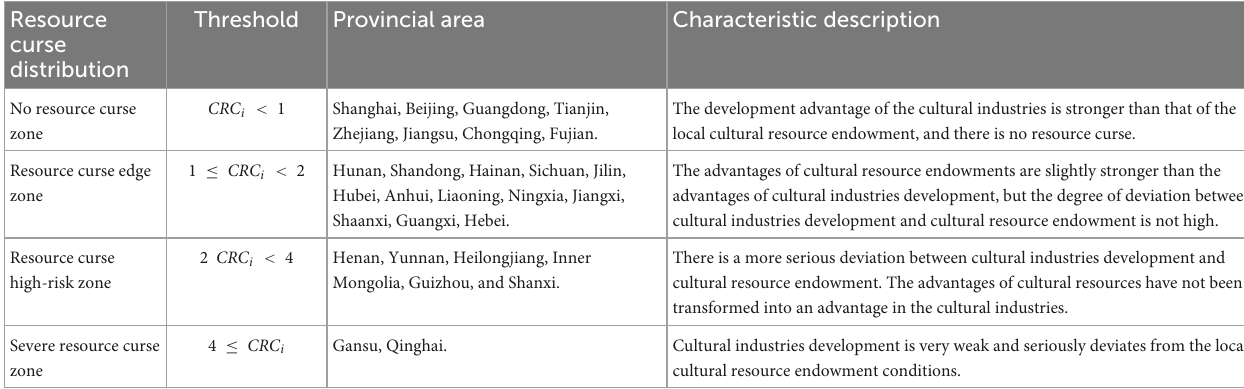
TABLE 2 Regional distribution of the cultural resource curse in China.